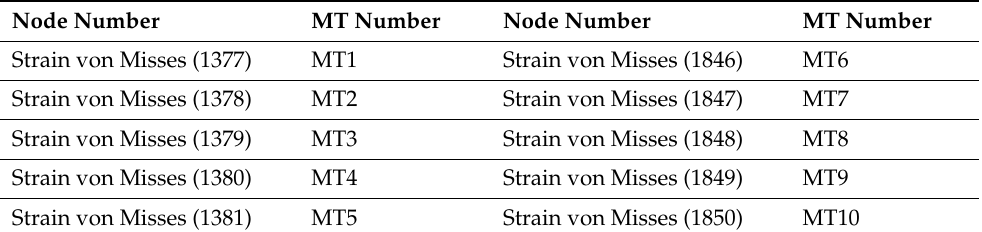
Table 3. Comparative presentation of the strain gauges and the corresponding finite element nodes. Node Number Node